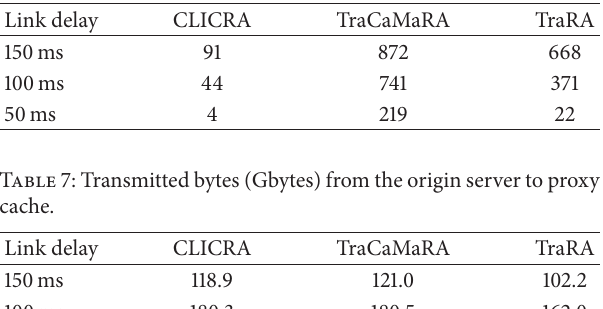
Table 6: Buffer under flow count for receive window 60 Kbytes.